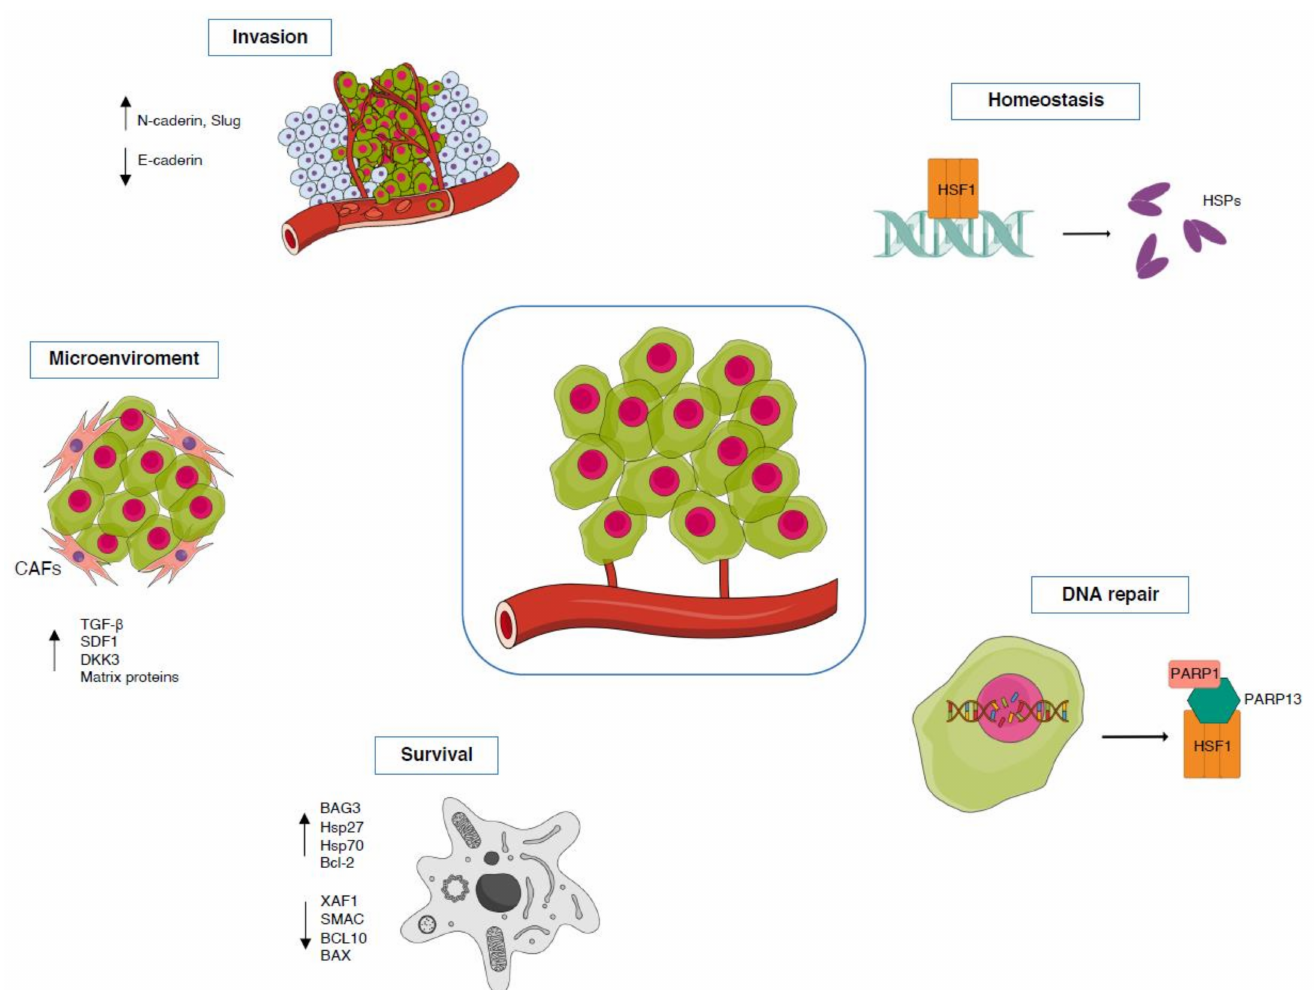
Figure 4. HSF1 multiple roles in cancer development. (Homeostasis) Mutated proteins accumulate in tumor leading to an increase in the HSPs production mediated by HSF1. (DNA repair) HSF1 regulates DNA repair in cancer cells by forming a ternary complex with PARP13 and PARP1 thus favoring PARP1 redistribution to DNA lesions. (Survival) HSF1 promotes cancer cell survival either by inducing the expression of genes encoding pro-survival proteins or repressing genes encoding pro-apoptotic factors. (Microenvironment) HSF1 modulates tumor microenvironment as it is activated in CAFs where regulates signaling pathways involved in ECM remodeling and cancer progression. (Invasion) HSF1 promote EMT either inducing the expression of N-cadherin and mesenchymal markers or downregulating the expression of E-cadherin and epithelial